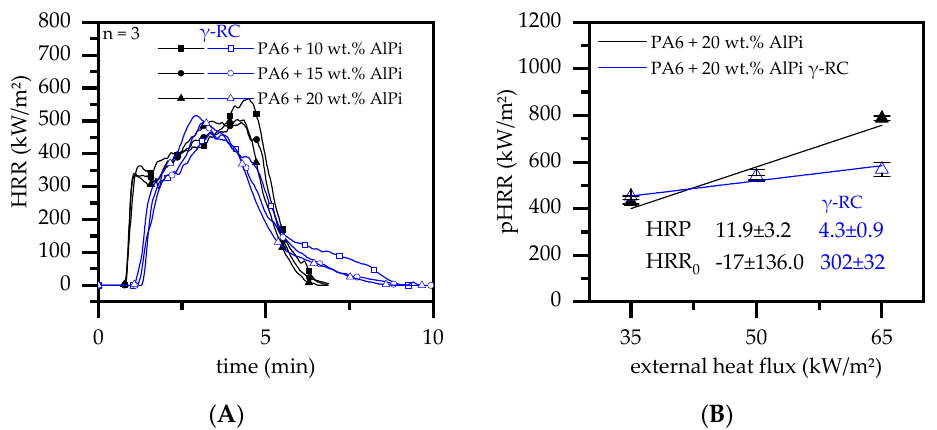
Figure 13. ( A ) HRR curves conducted by cone calorimeter testing for net and β -radiation β -RC PA6/AlPi formulations at 50 kW/m 2 . ( B ) pHRR conducted by cone calorimeter tests at external heat fluxes of 35, 50 and 65 kW/m 2 . A linear fit was used to evaluate the HRP and corresponding y-cross point HRR 0 .